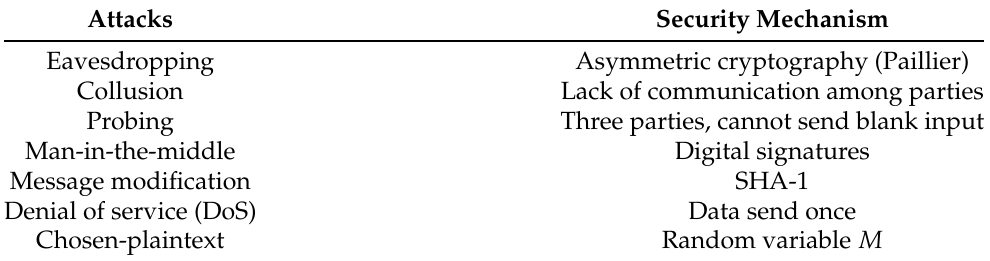
Table 7. Possible security threats and their